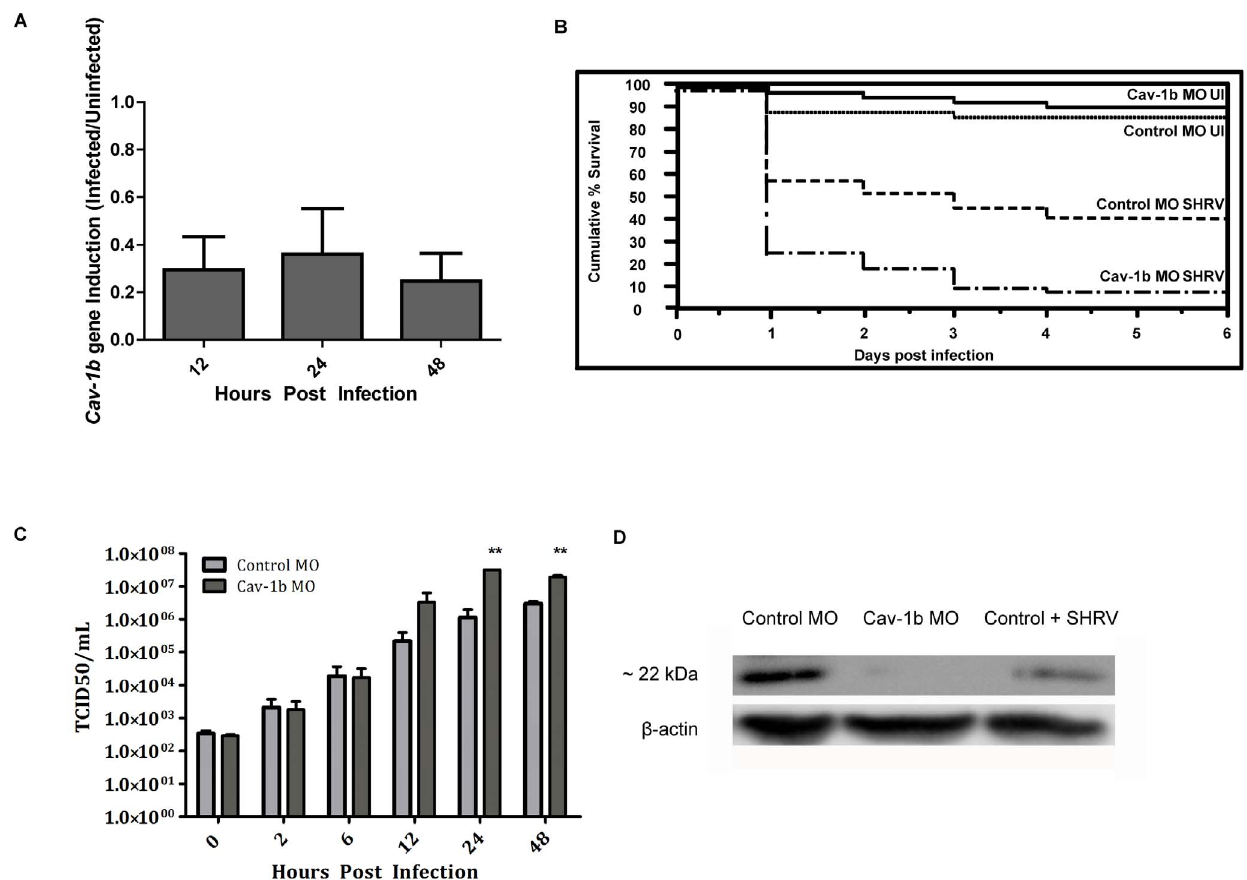
Figure 2. Cav-1b expression is modulated during virus infection, and Cav-1b knockdown leaves morphants susceptible to infection. A) Quantitative RT-PCR results revealed fold changes in the expression levels of Cav-1b in infected embryos when compared to uninfected embryos. Zebrafish were exposed seven dpf to 1 6 10 6 TCID 50 /mL virus. Total RNA was isolated from at 12, 24, and 48 hours post infection and reverse transcribed to cDNA (n=20 fish per time point). All expression values have been normalized to the zebrafish b -actin gene. Error bars represent SEM of three replicates. B) Zebrafish embryos that were injected with Cav-1b morpholino (MO) to knock down the expression of Cav-1b or control MO were infected 48 hpf with 1 6 10 6 TCID 50 /ml virus and monitored for mortality. Results are representative of three separate experiments. Statistical analysis (Wilcoxon test) of the Kaplan-Meier curve was performed (*, p=0.008). C) Zebrafish embryos that were injected with Cav-1b MO to knock down the expression of Cav-1b or control MO were infected by static immersion 48 hpf with 1 6 10 6 TCID 50 /ml virus. The graph indicates that early in infection (0–12 hpi), there is no difference in viral burden between Cav-1b morphants and controls. However, by 24–48 hpi, Cav-1b morphants have a higher viral burden. Figure is representative of three experiments; error bars are standard error of the mean (*, p , 0.05). D) Western blot showing efficacy of MO knockdown in zebrafish. Zebrafish embryos from Control and Cav-1b MO, and Control MO with SHRV infection were compared for cav-1b expression at the 72 hpf developmental stage. At this time, infected fish were 24 hpi. Membranes were re-probed with antibody against b -actin to control for protein loading.